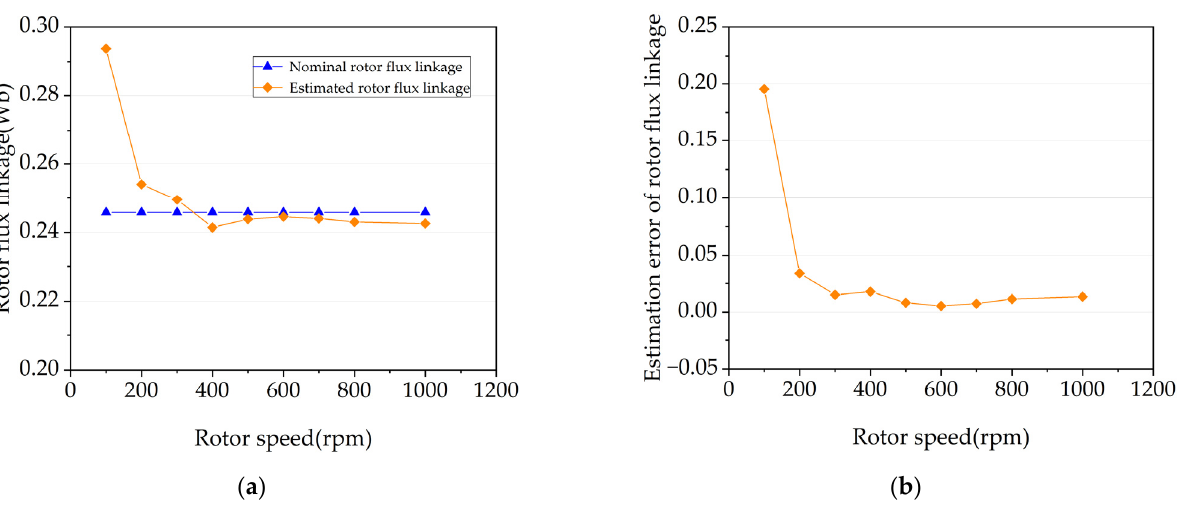
Figure 12. Estimated rotor flux linkage and its estimation error with respect to different initial rotor speeds of free-running. ( a ) Nominal and estimated rotor flux linkage; ( b ) estimation error of rotor flux linkage.